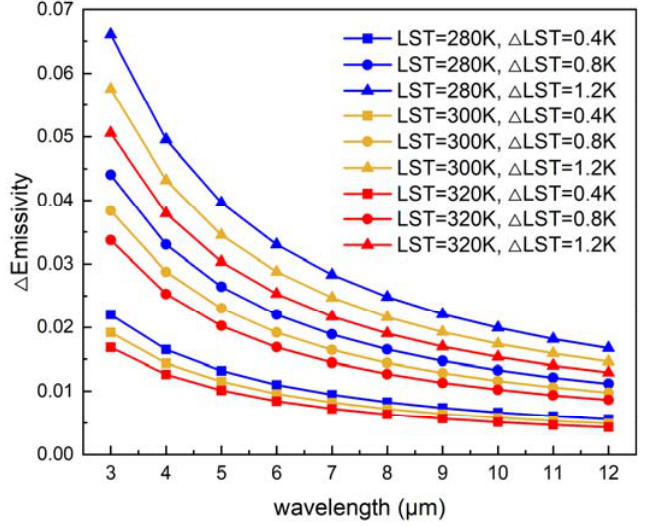
Figure 7. Errors of emissivity as a function of wavelength.